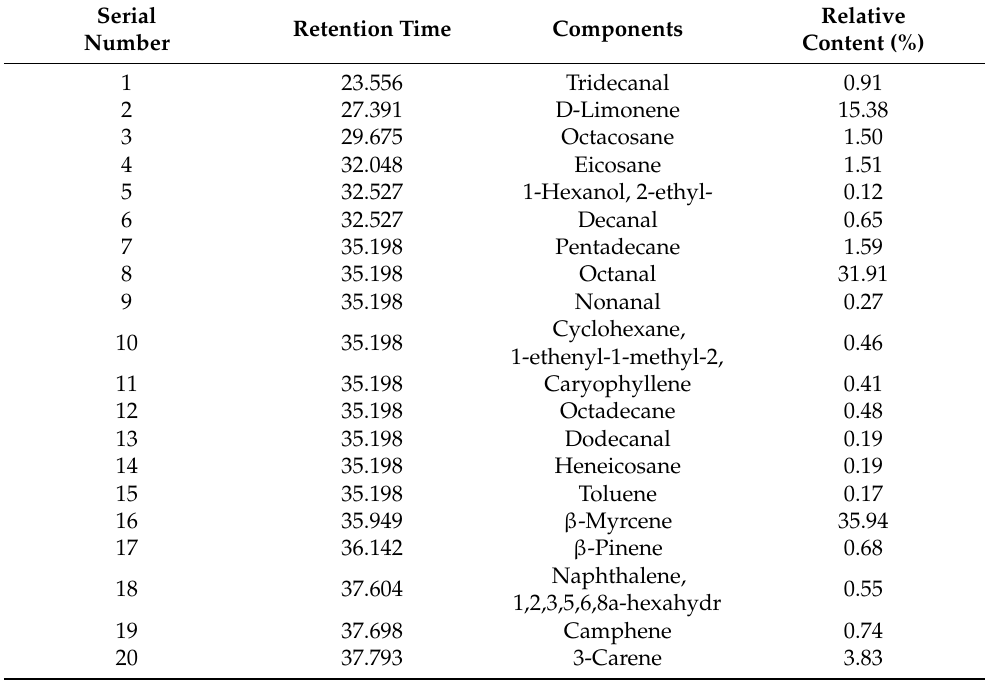
Table 4. Analysis of components of